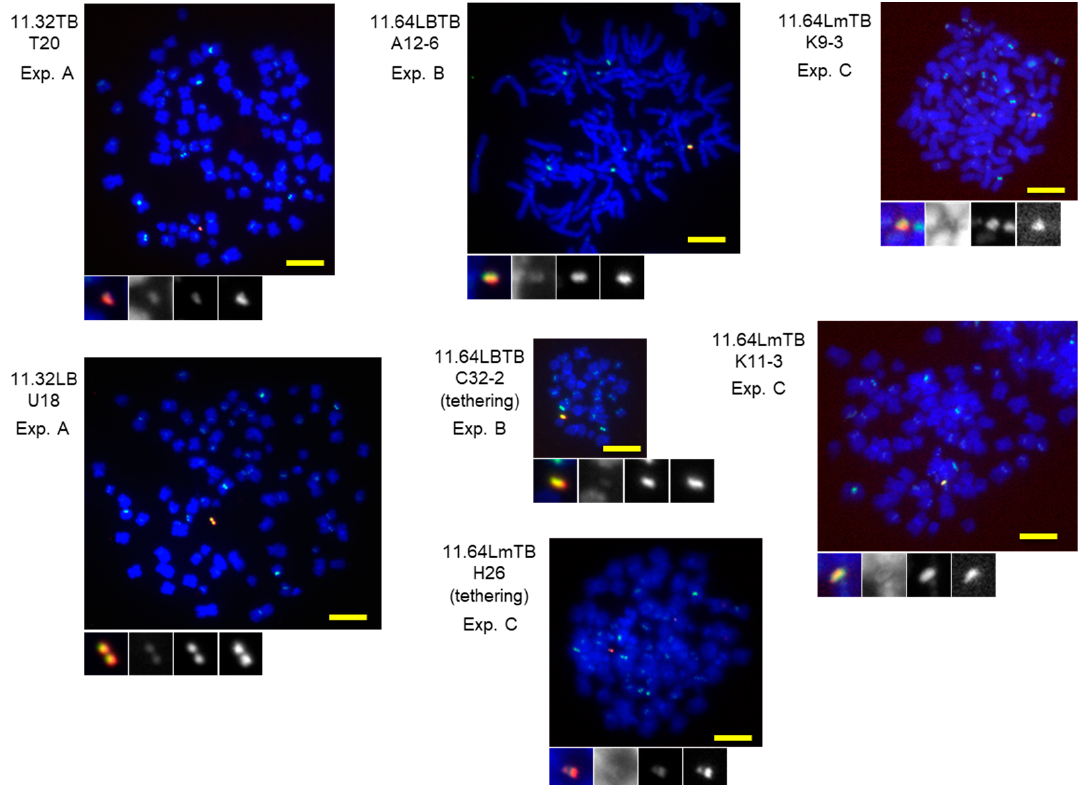
Figure 4. FISH analysis of the HACs obtained using the synthetic alphoid arrays. Chromosome spreads of the clones were hybridized with probes for α 21-I (green) and BAC (red) and stained with DAPI (blue). Scale bar = 5 μ m. Below each panel, the HAC area is magnified, and the color is split into black-and-white images for DAPI, α 21-I and BAC, in that order.